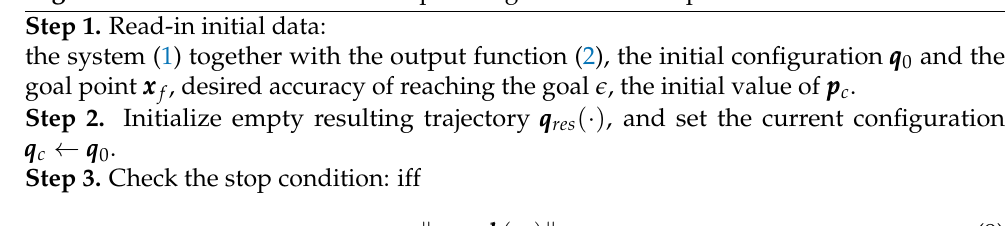
Algorithm 1 nonholonomic motion planning within a